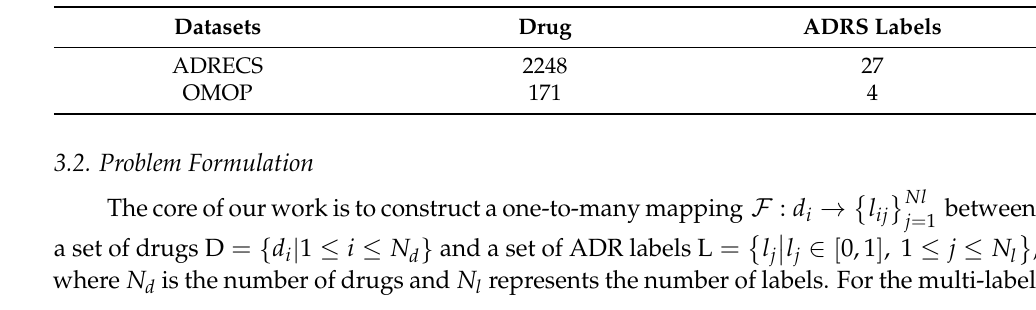
Table 4. Dataset statistics.